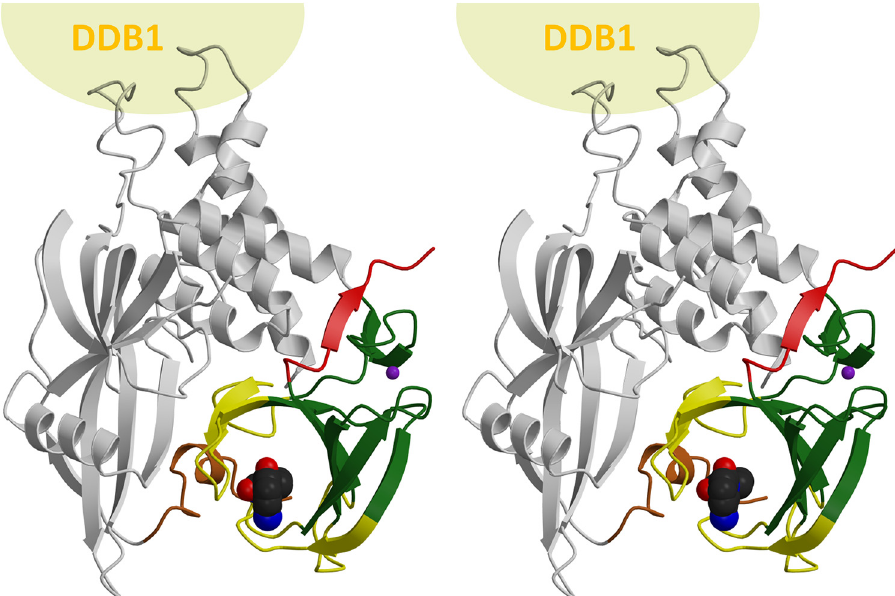
Fig 7. The flexible regions and mental retardation mutation in the context of human full length cereblon. At the top, interaction partner DDB1 is represented by a sphere. The thalidomide binding domain is in green (rigid core), yellow (flexible regions) and red (deleted C-terminal part in the MsCI4 WWK/FFX mutant). The exact boundaries of the segments are defined in Fig 2. The N-terminal extension of cereblon is in brown, the remainder of the protein